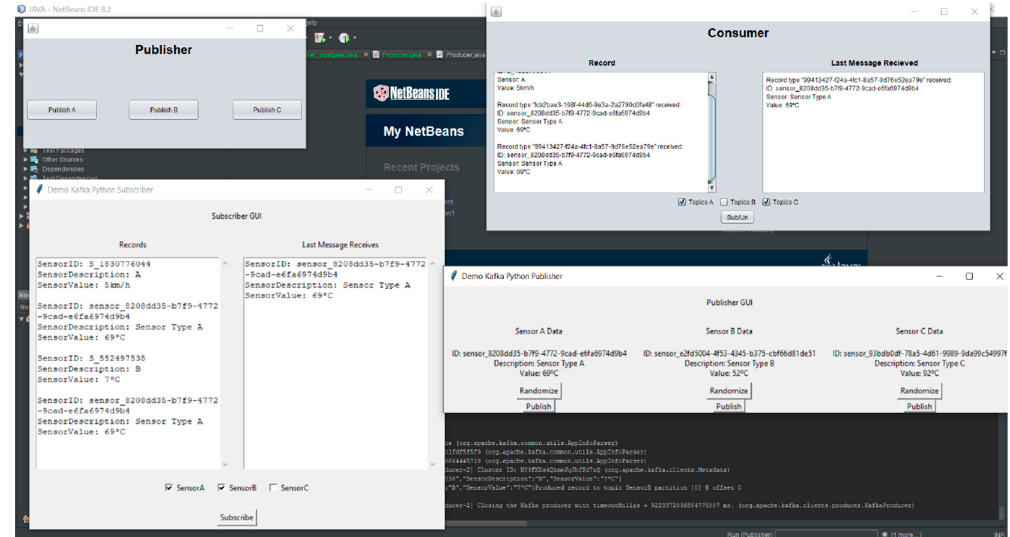
Figure 4. Demonstration using Java and Python Publishers and Subscribers.